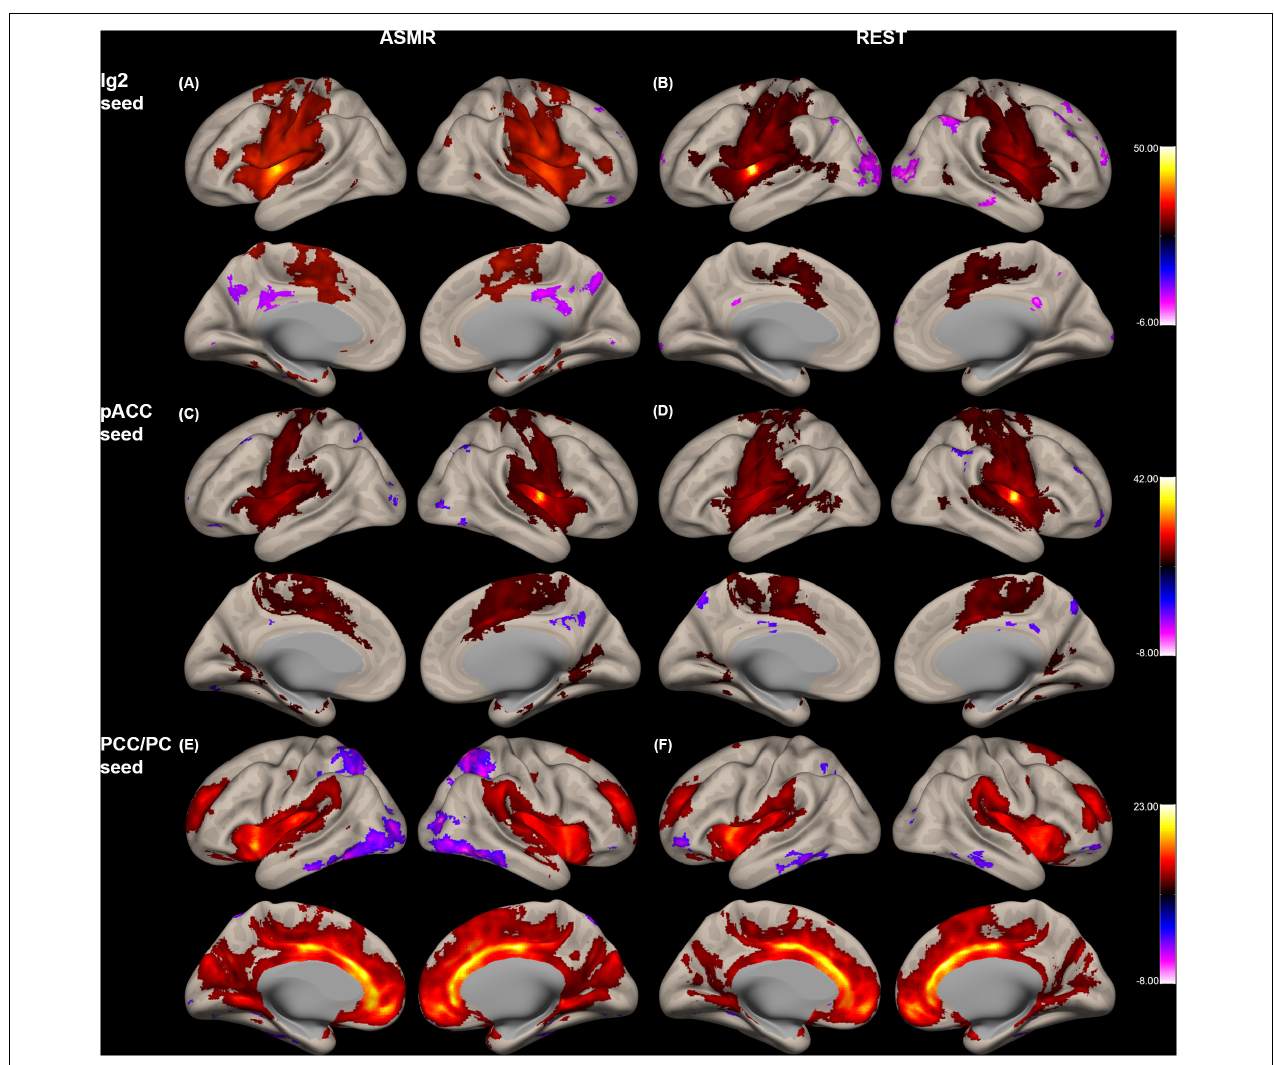
FIGURE 2 | Group-level functional connectivity of the t -statistic in the other networks during resting-state, and in response to ASMR effects. Functional connectivity strengths in terms of t -statistics were thresholded at a significance level of false discovery rate (FDR)-corrected p < 0.05, and overlaid on a cortical surface atlas. Functional connectivity of the right posterior insular cortex seed (Ig2) region in response to ASMR (A) , and in resting-state (B) . Functional connectivity of the pregenual anterior cingulate cortex (pACC) seed region in response to ASMR (C) , and in resting-state (D) . Functional connectivity of the posterior cingulate cortex/precuneus (PCC/PC) seed regions in response to ASMR (E) , and in resting state (F)